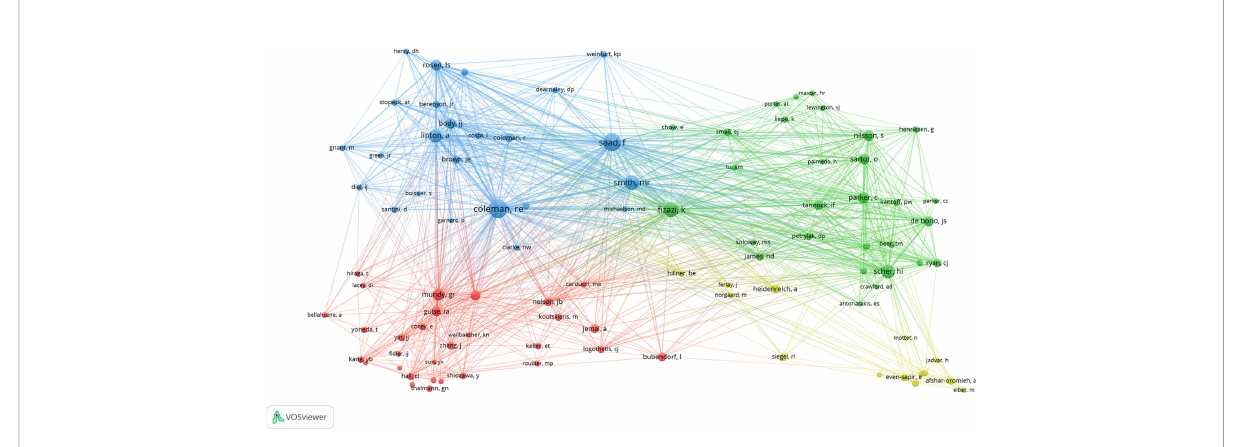
FIGURE 5 Visualization map of co-cited authors generated by VOSviewer.